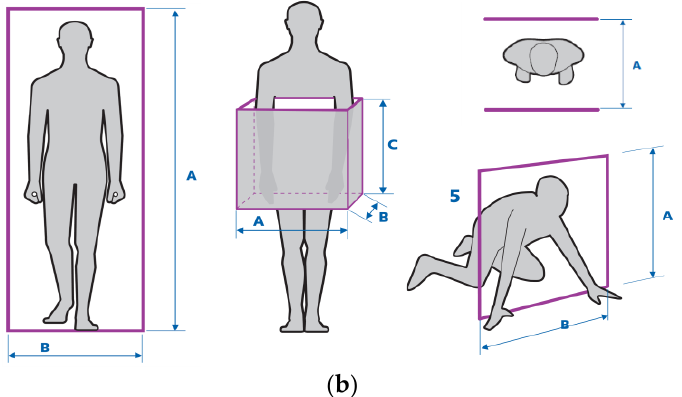
Figure 1. Illustration of geometric figures modeling/approximating the actual shapes of confined spaces: ( a ) circle/cylinder; ( b ) rectangle/cuboid [13].